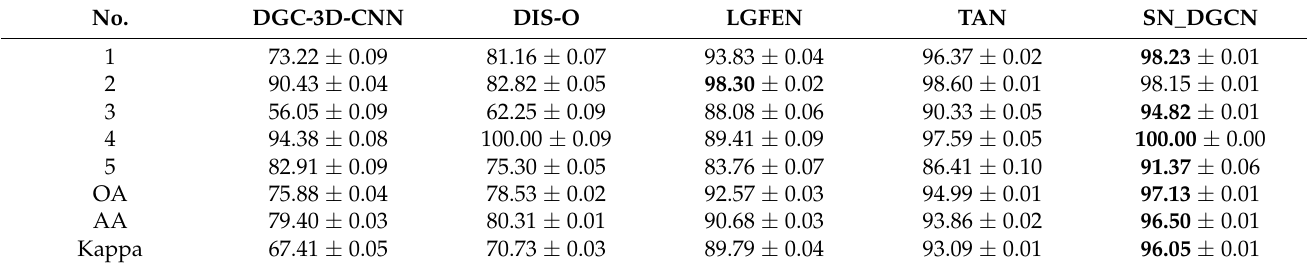
Table 3. Performance comparison with existing desert grassland deep learning models (%). Note: Bold represents the highest classification accuracy.